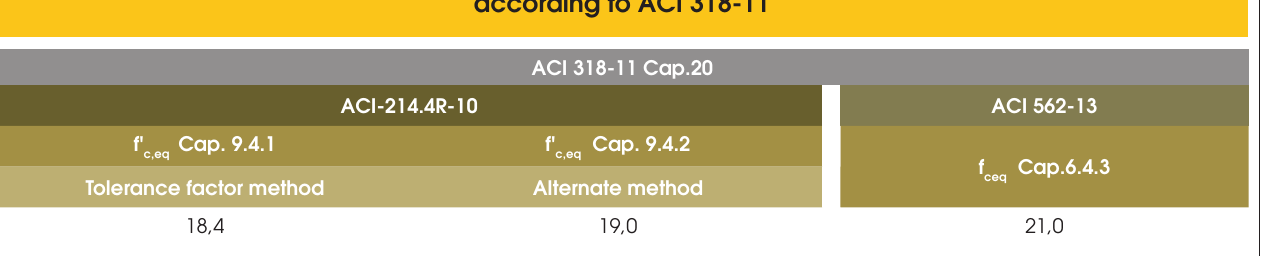
Table 10 – Values of f according to EN 13791:2007 (assuming g f ck,is EN 13791